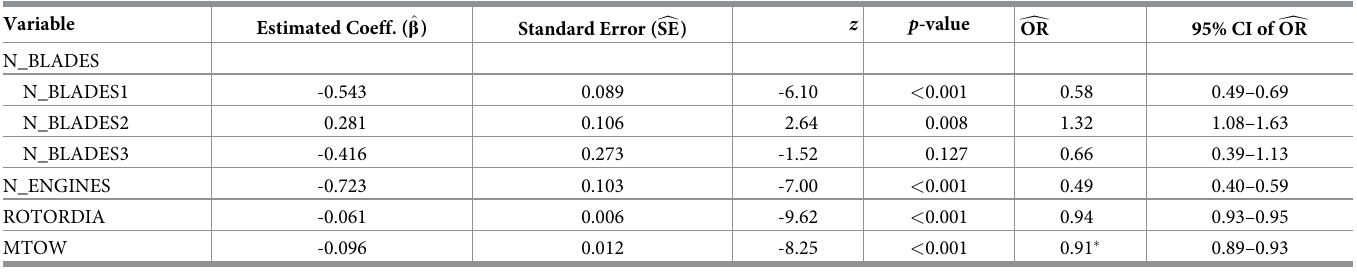
Table 3. Results of fitting univariate logistic regression model in the turboshaft helicopter data (one covariate at a time). Variable Estimated Coeff. ( ^ β